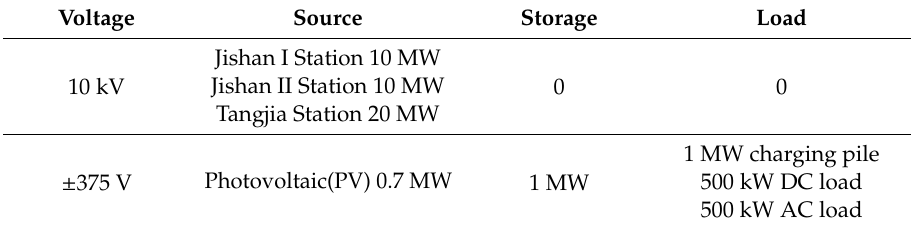
Table 2. Type and capacity of source, storage and load in a 10 kV AC / DC hybrid distribution network.